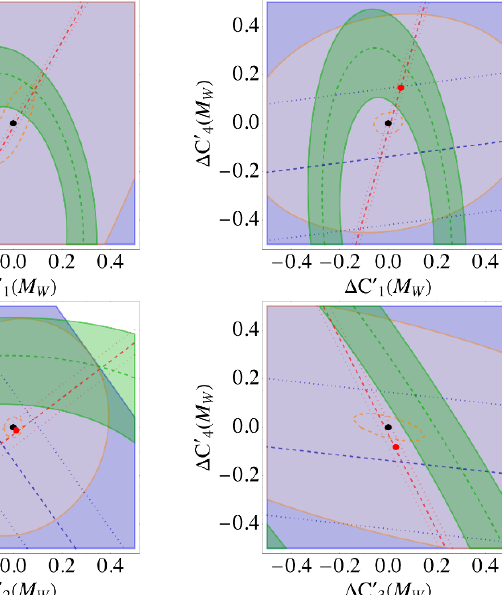
= 0 : 09 0 : 15 (red, dashed) and of (cid:22) C 0 e(cid:11) 9 (cid:6)